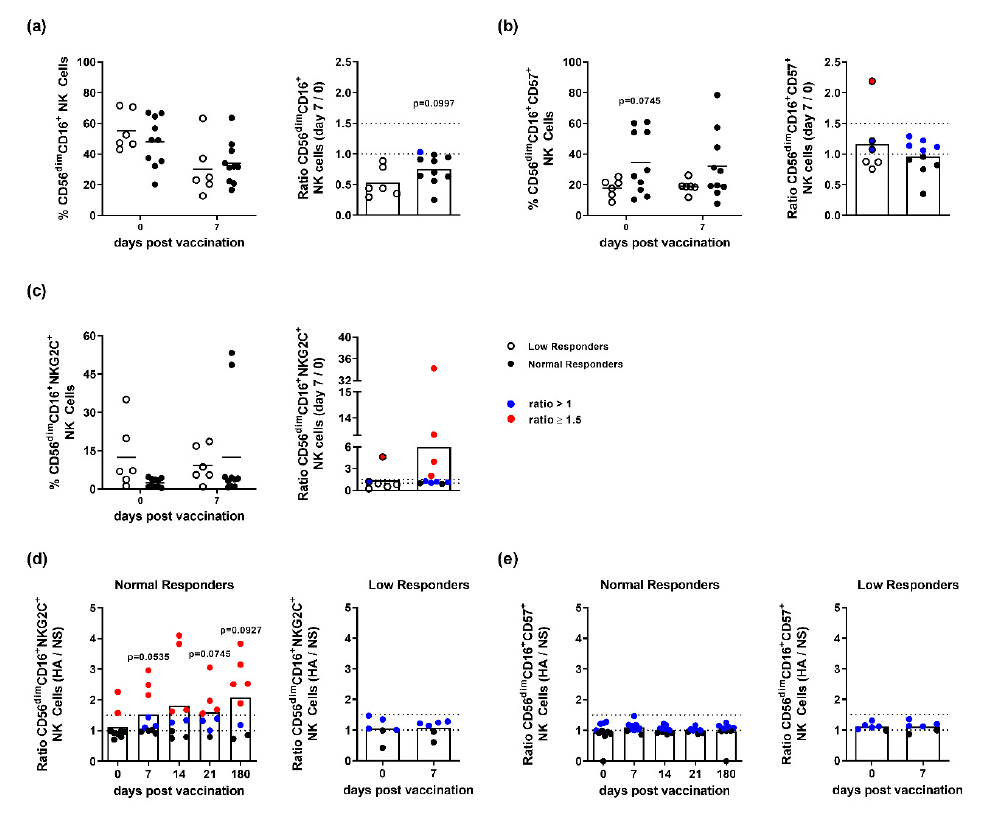
Figure 2. Phenotypic analysis of NK cells derived from normal and low responders to the pandemic influenza vaccination. Flow cytometric analysis of frozen PBMCs isolated from vaccinated individuals classified into normal responders (black dots) and low responders (white dots; a-c). Frequencies and ratios of ( a ) CD56 dim CD16 + , ( b ) CD56 dim CD16 + CD57 + and ( c ) CD56 dim CD16 + NKG2C + NK cells. Diagrams are depicted as scatter dot plots indicating the mean by a horizontal line. Ratios were derived from cell frequencies detected at day 7 post-vaccination and the frequencies detected prior to vaccination (day 0) depicted as scatter plots with bars. Ratios of unstimulated (NS) and HA-re-stimulated (HA) ( d ) CD56 dim CD16 + NKG2C + and ( e ) CD56 dim CD16 + CD57 + NK cells derived from normal and low responders. Blue dots depict ratios >1 and red dots depict values ≥ 1.5.